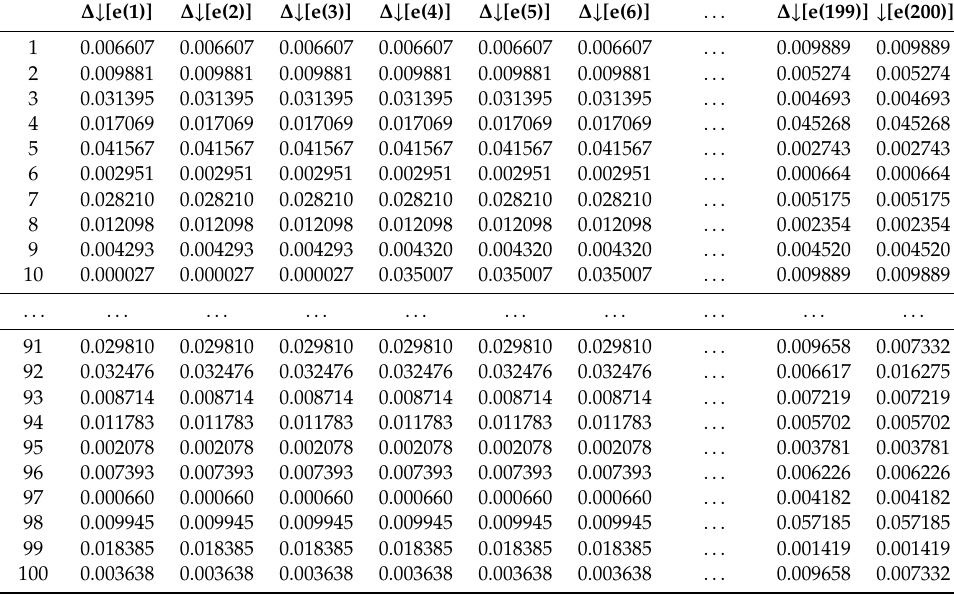
Table 4. Consecutive di ff erences of sorted random numbers ∆ ↓ [e( i )], i ∈ [1,